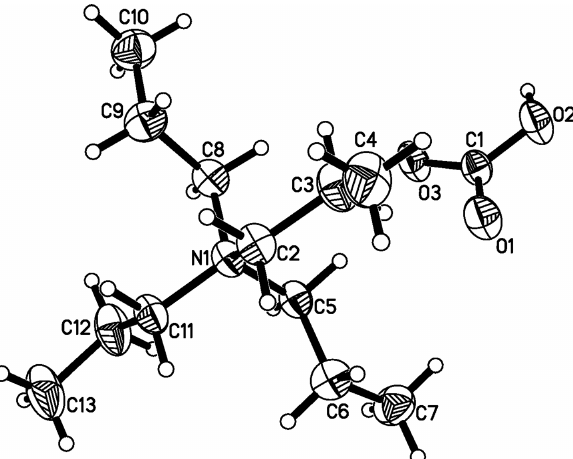
Table 1: Data collection and